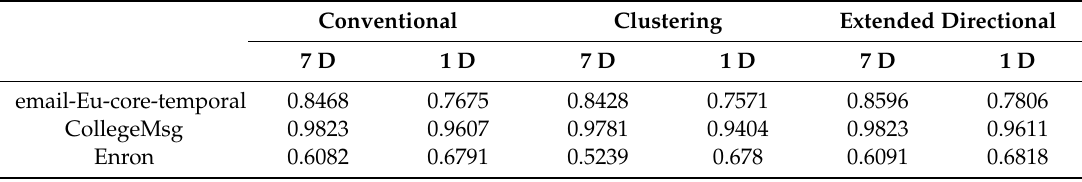
Table 9. Comparison of model fit for the three datasets (expressed as R 2